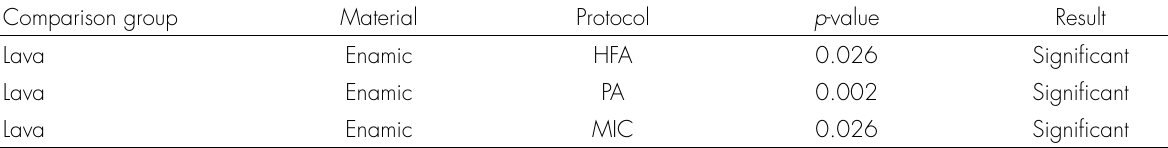
Table III. Comparison of Lava™ Ultimate values with Enamic ® for each etching protocol.